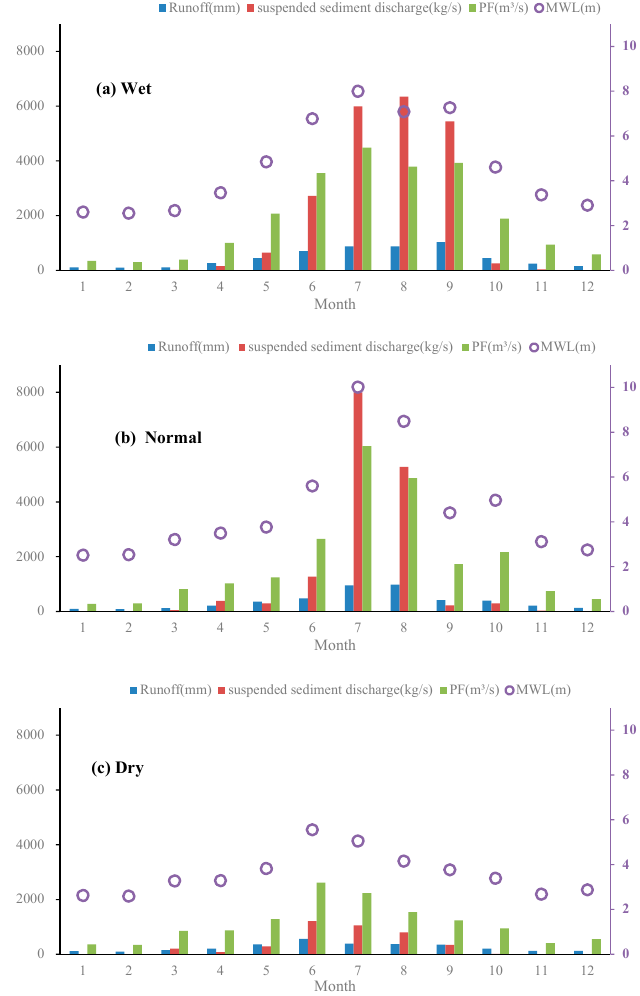
Figure 2. The suspended sediment discharge, runoff, peak flow (PF), low flow (LF), and maximum water level (MWL) of wet, normal, and dry flow years at Jiuzhou Station.